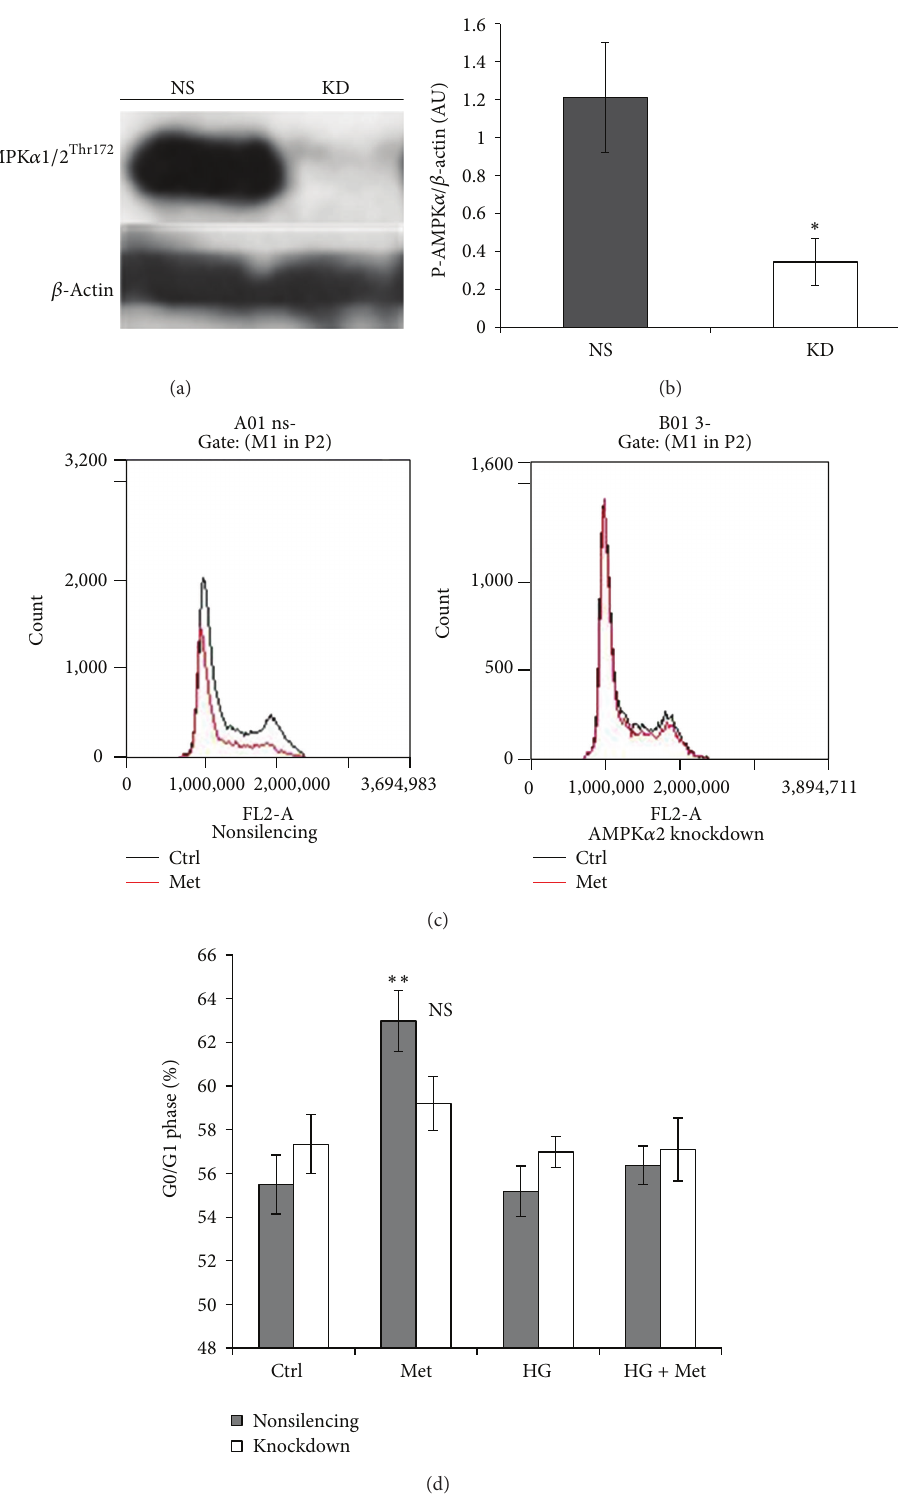
Figure 3: Metformin does not induce cell cycle arrest in AMPK 𝛼 2-deficient cells. (a) Representative western blot image showing the effect of AMPK 𝛼 2 knockdown, nonsilencing control (NS), knockdown (KD). (b) Densitometry analysis of P-AMPK 𝛼 expression (mean ± SEM, ∗ 𝑃 < 0.05 ). (c) Flow cytometry panels representing the effect of AMPK 𝛼 2 knockdown on cell cycle arrest induced by 8mM metformin (Met), compared with control (Ctrl). (d) High glucose treatment is comparable to AMPK 𝛼 2-deficiency. The cells were cultured in 5.5 mM NG, 25 mM D-glucose (HG), for 48h. For the last 24 h, 8 mM metformin (Met) was added in the indicated conditions. Data expressed as mean + SEM. NS 𝑃 > 0.05 ; ∗∗ 𝑃 < 0.01 , compared with